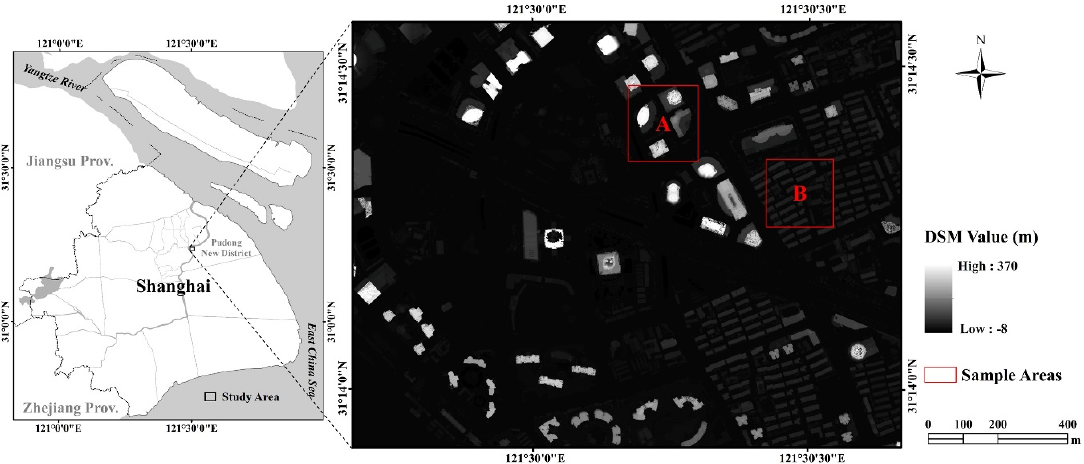
Figure 1. The geographic location and Digital Surface Model (DSM) from airborne Light Detection and Ranging (LiDAR) data of the Lujiazui region, Shanghai, China. Ranging (LiDAR) data of the Lujiazui region, Shanghai,